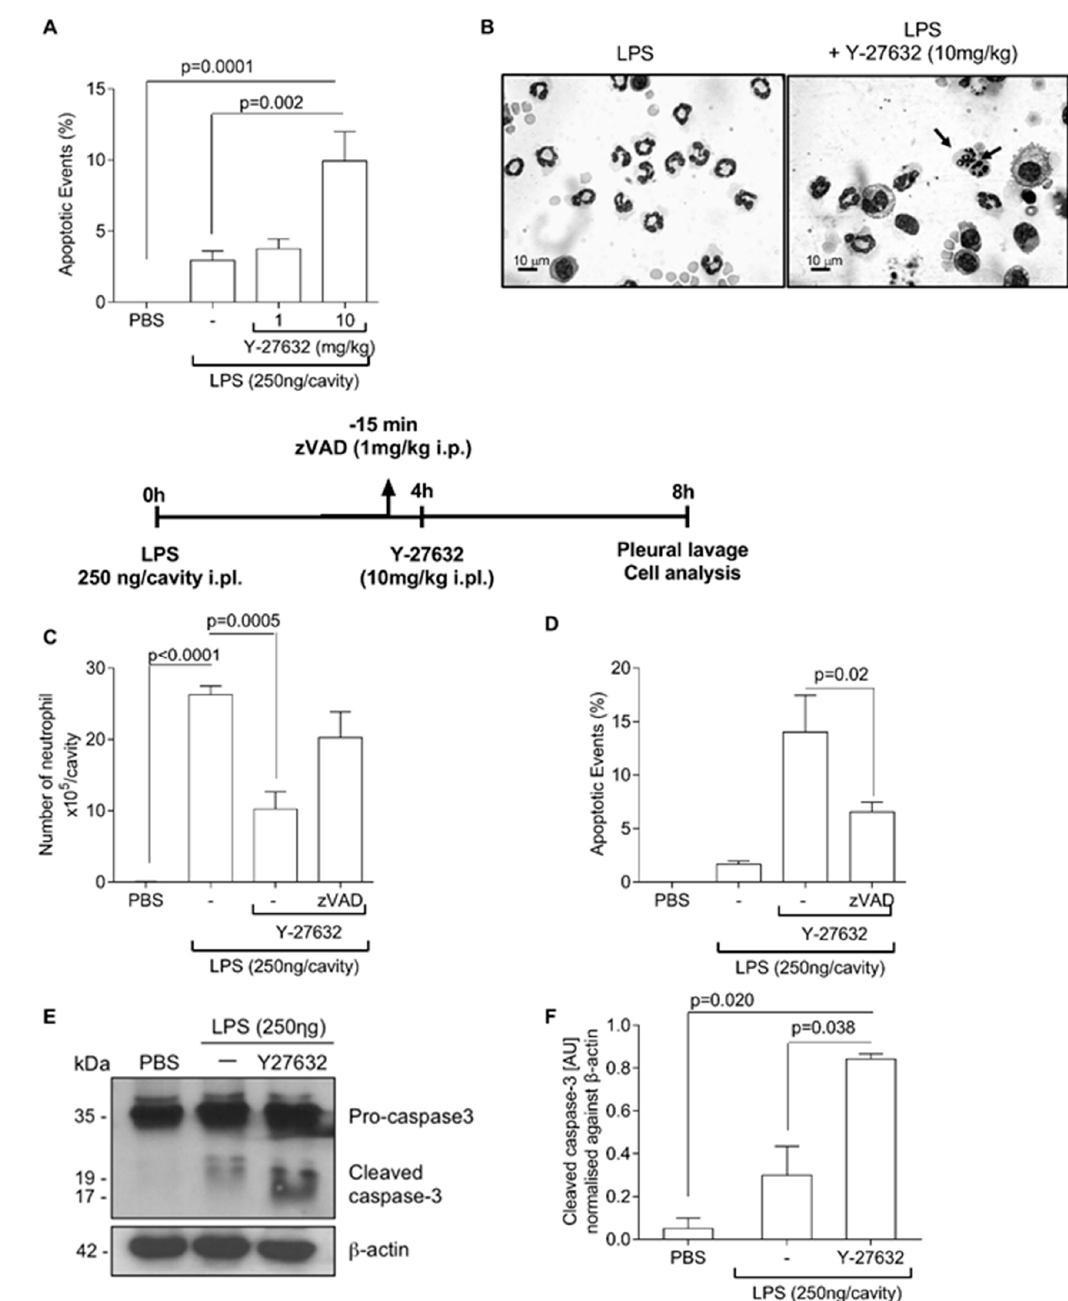
Figure 2. Effect of Y-27632 treatment on neutrophil apoptosis. Mice were injected with PBS or LPS (250 ng/cavity, i.pl.) and, 4 h later, received a local injection (i.pl.) of Y-27632 (1 or 10 mg/kg, i.pl.) or vehicle. Cells with distinctive apoptotic morphology were evaluated 4 h after drug treatment and are expressed as percent of neutrophils with distinctive apoptotic morphology ( A ) Representative figures of viable and apoptotic neutrophils (arrow) ( B ). Scale bar = 10 μ m. Original magnifications, ×40. The pan-caspase inhibitor zVAD-fmk (1 mg/kg, i.p.) was given 15 min before ROCK inhibition (Y-27632 10 mg/kg, i.pl.). The number of neutrophils ( C ), cells with distinctive apoptotic morphology ( D ) and Western blot to detection of pro-caspase 3 and cleaved caspase-3 ( E ) were evaluated 4 h after drug treatment. Densitometry analysis of Western blot are shown ( F ). Results are expressed as the number of cells/cavity and are shown as the mean ± SEM of five mice in each group (ANOVA test followed by Holm-Sidak’s multiple comparison).